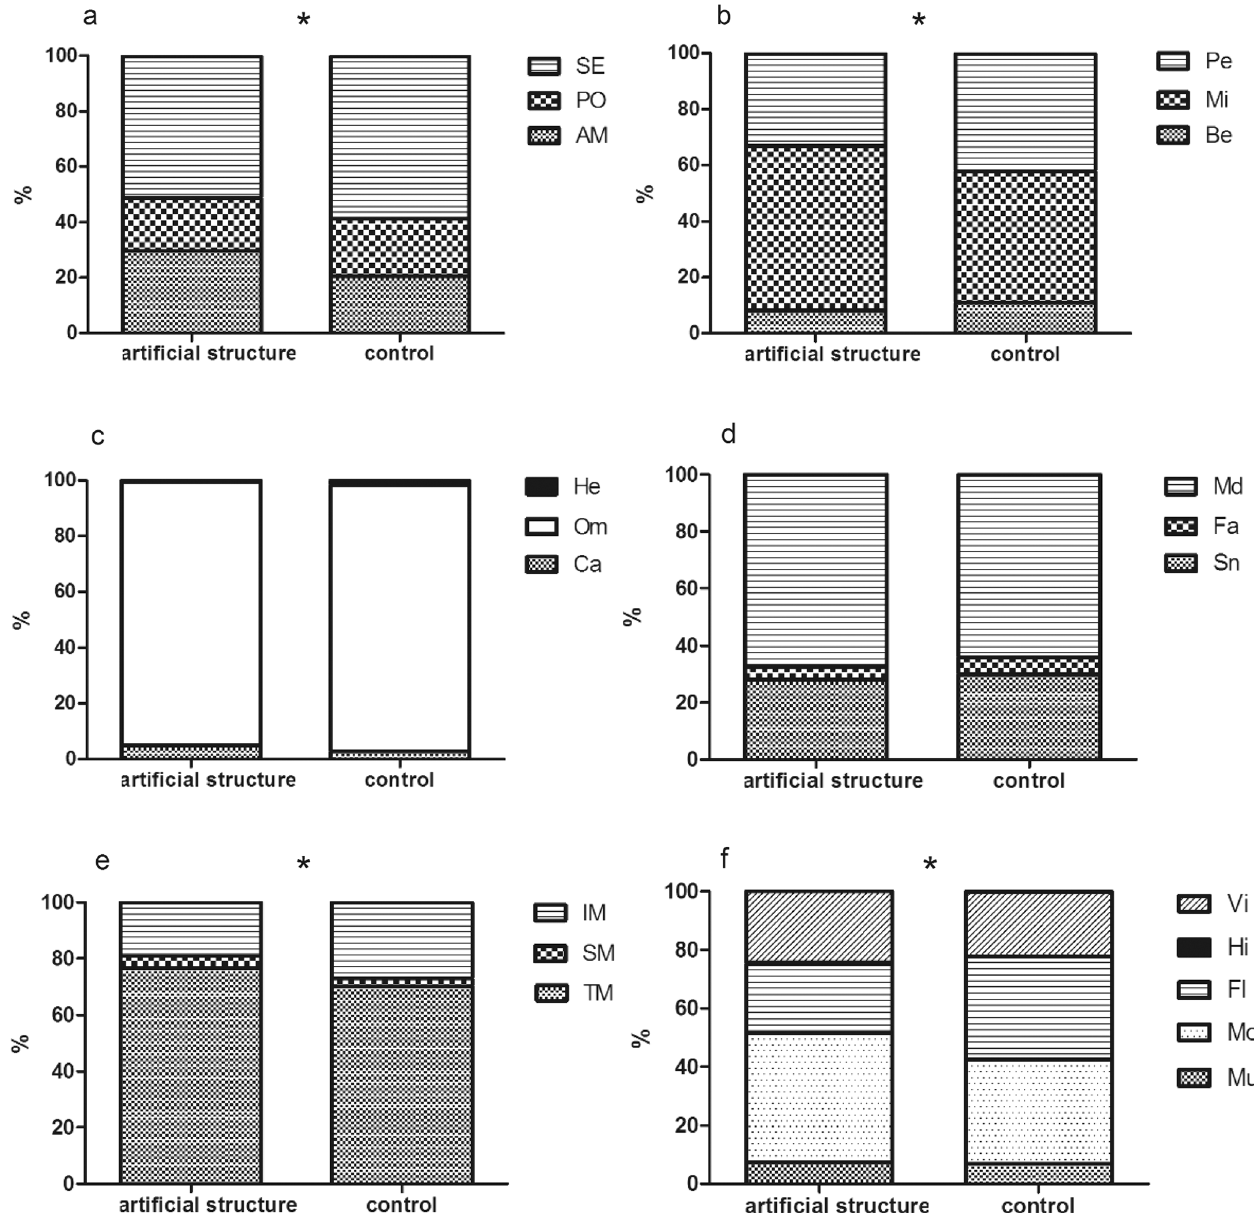
Fig. 6. Comparison of composition of ecological traits between arti fi cial structures and control sites. (a) migratory type (SE: sedentary species, PO: potamodromous species, and AM: amphidromous species); (b) habitat (Pe: pelagic fi sh, Mi: mid-water fi sh, Be: benthic fi sh); (c) trophic guild (He: herbivore, Om: omnivore, Ca: carnivore); (d) (4) current preference (Fa: fast, Md: moderate, Sn: slow-none); (e) mouth type (IM: inferior Mouth, SM: superior mouth, TM: terminal mouth); (f) egg type (Vi: viscous egg, Hi: hidden egg, Fl: fl oating egg, Mo: mouth brooding egg, Mu: spawn-in-mussel egg). *signi fi cant between arti fi cial structures and control sites by chi-square test at the 0.05